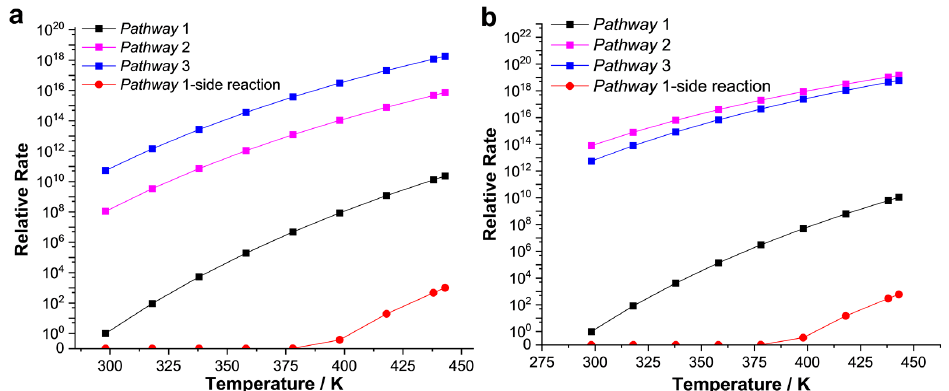
Figure 8. Chemical kinetics studies for catalytic system CAT-1 ( a ) and CAT-2 ( b ). Reaction rate constants versus the reaction temperature were carried out via TST calculation. The relative rate unit of CAT-1 and CAT-2 are 5.3 × 10 − 30 s − 1 and 2.3 × 10 − 29 s − 1 , respectively.